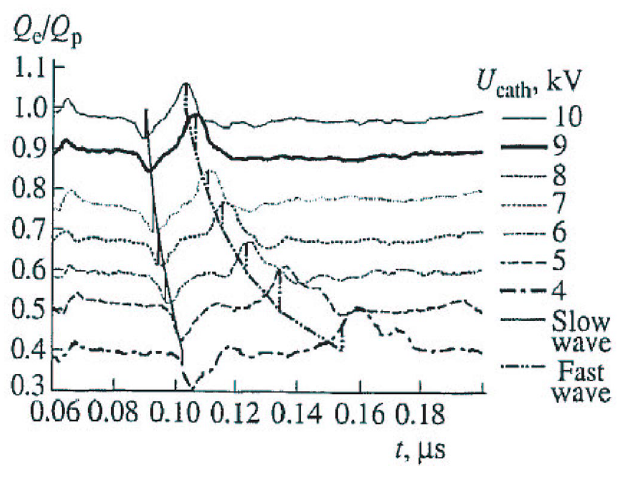
82. (Color) Charge disturbance in the TEL electron beam detected by a pickup, as a function of time over the first 200 ns after a proton-bunch transit; the different curves refer to various TEL electron-beam energies (cathode voltages); they are sepa- rated by 0.1 units in the vertical direction [98]; a fast wave and a slow wave are evident.